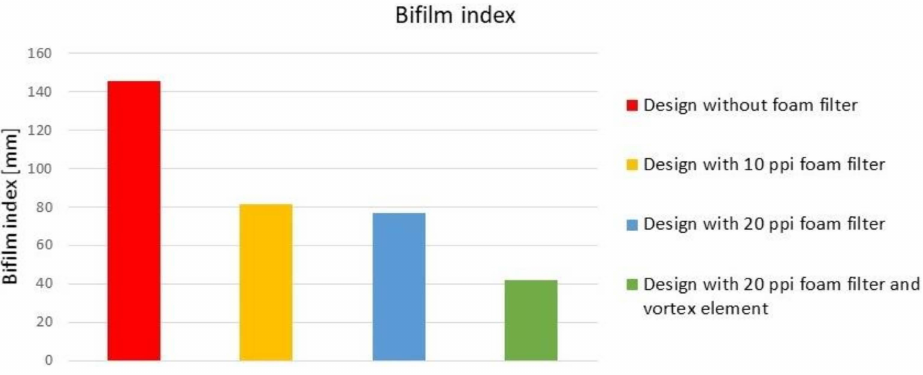
Figure 15. Results of bifilm index evaluation.